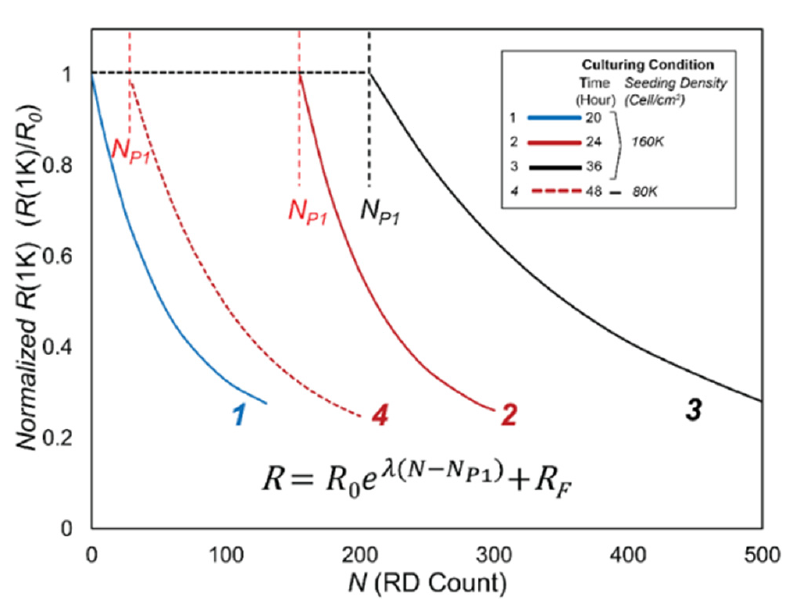
R (1K) scaled on R 0 . Table 1a provides the values of N P 1 and λ , with the mean and standard deviation of n = 7 measurements.